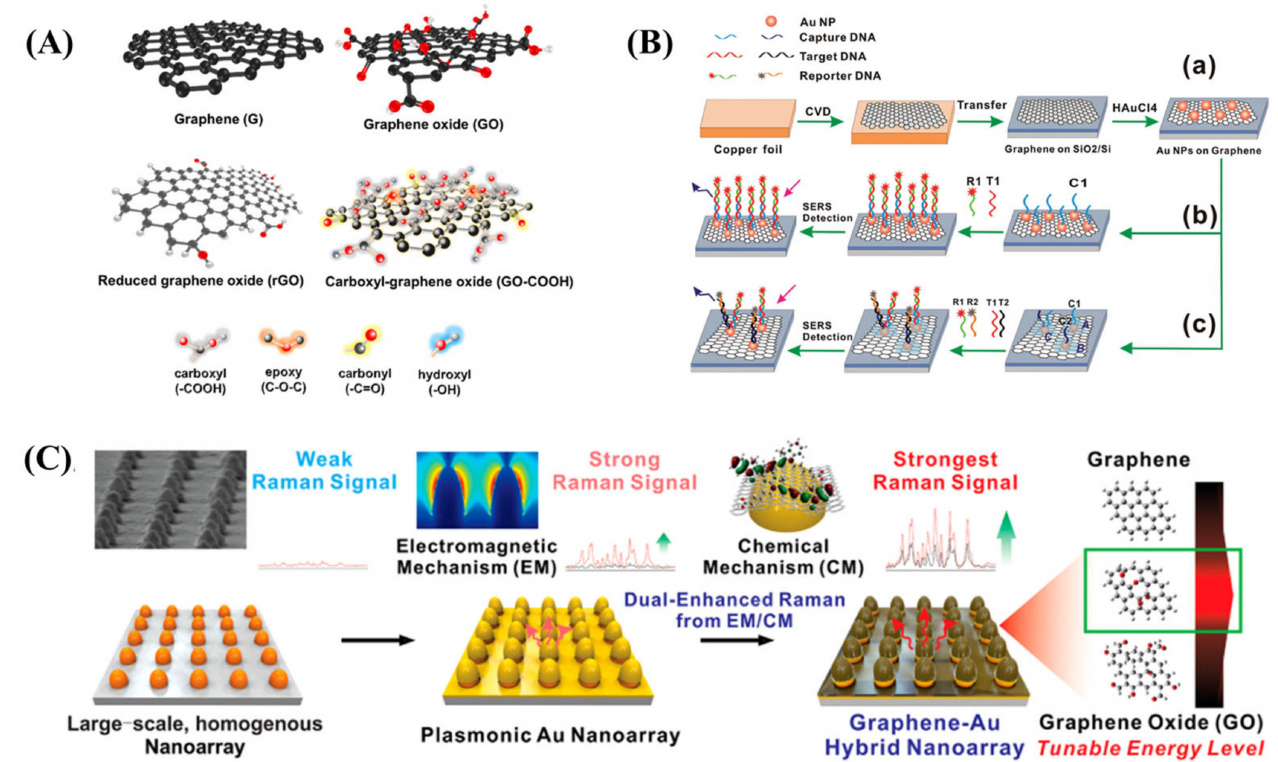
Figure 3. ( A ) Graphene and its derivatives [31], ( B ) Schematic illustration of the fabrication of SERS-active substrate and its application for DNA detection. Step ( a ) shows the graphene growth on copper foil by CVD, Step ( b , c ) represents the detection of single target and multiplex detection of two different target DNAs, respectively, by GO-Au hybrid SERS sensor [115]. ( C ) Schematic diagram illustrating graphene-coated AuNPs SERS nanoarray for the characterization of neuronal differentiation